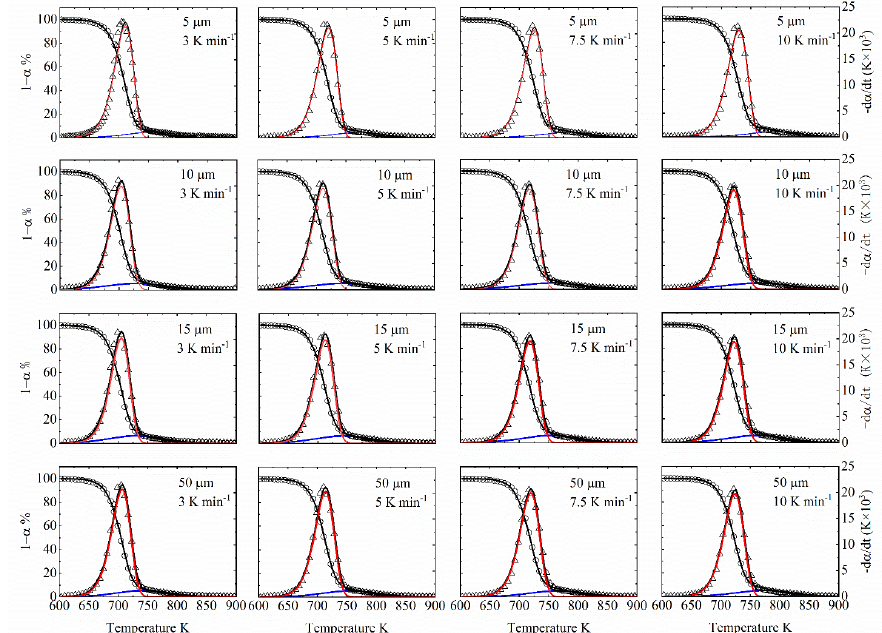
Figure 8. Comparison between DAEM calculation (solid lines, including α and d α / d t for overall reaction and step reactions) and experimental data (points, including α and d α / d t ) for di ff erent particle size with di ff erent heating rates.